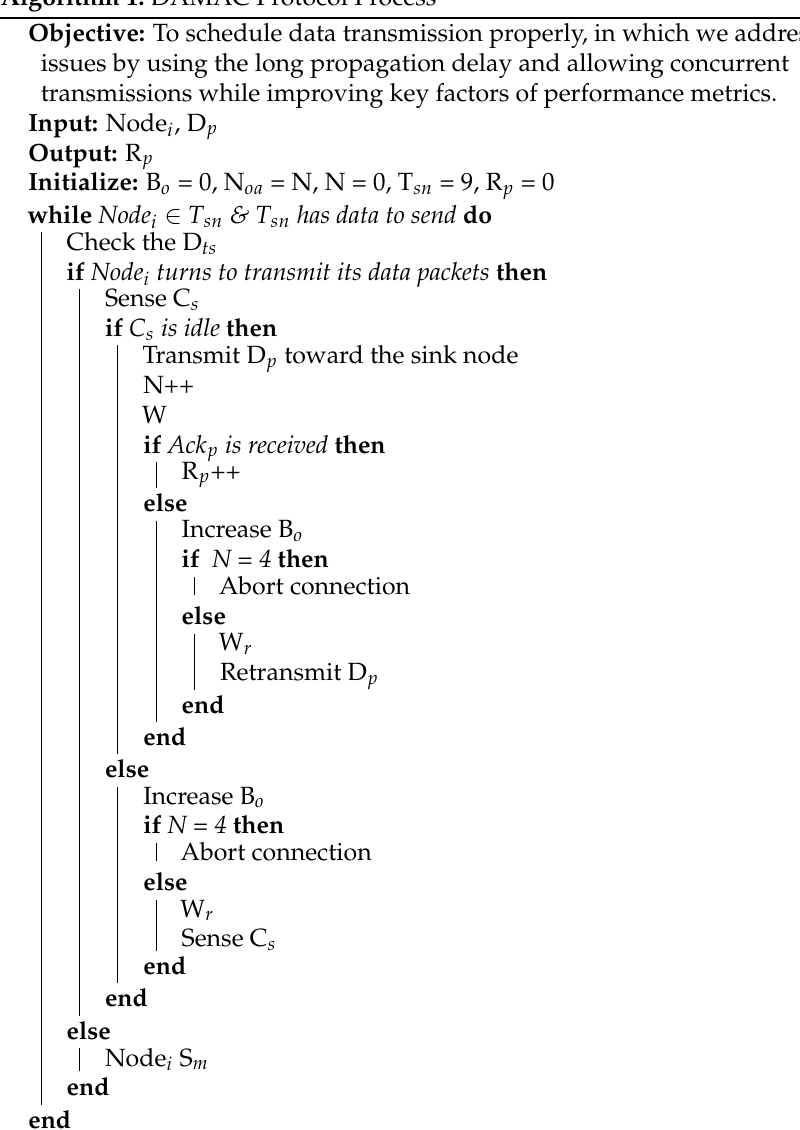
Algorithm 1: DAMAC Protocol